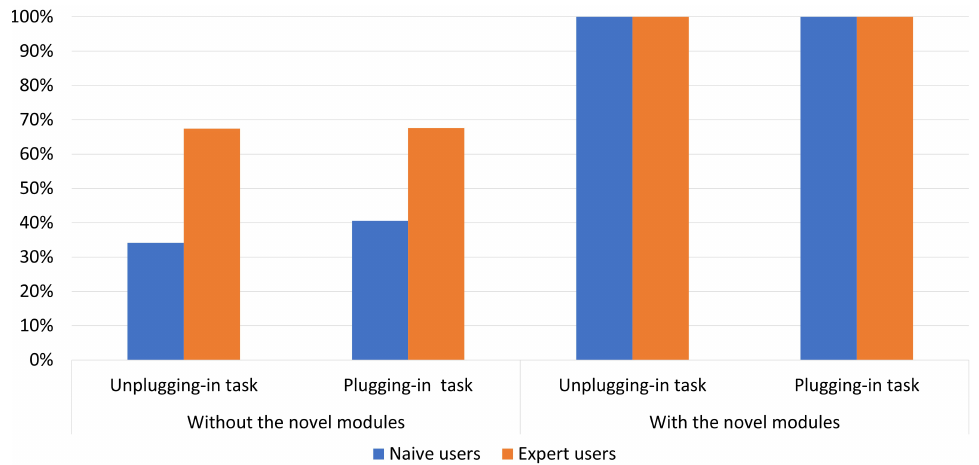
Figure 10. Overall relative efficiency of the two tasks performed without and with the two novel